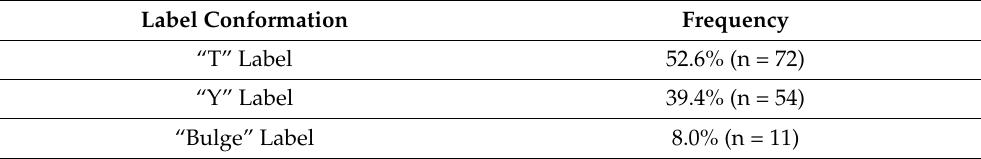
Table 1. The yield of different arrangements of the arms of the junction label.